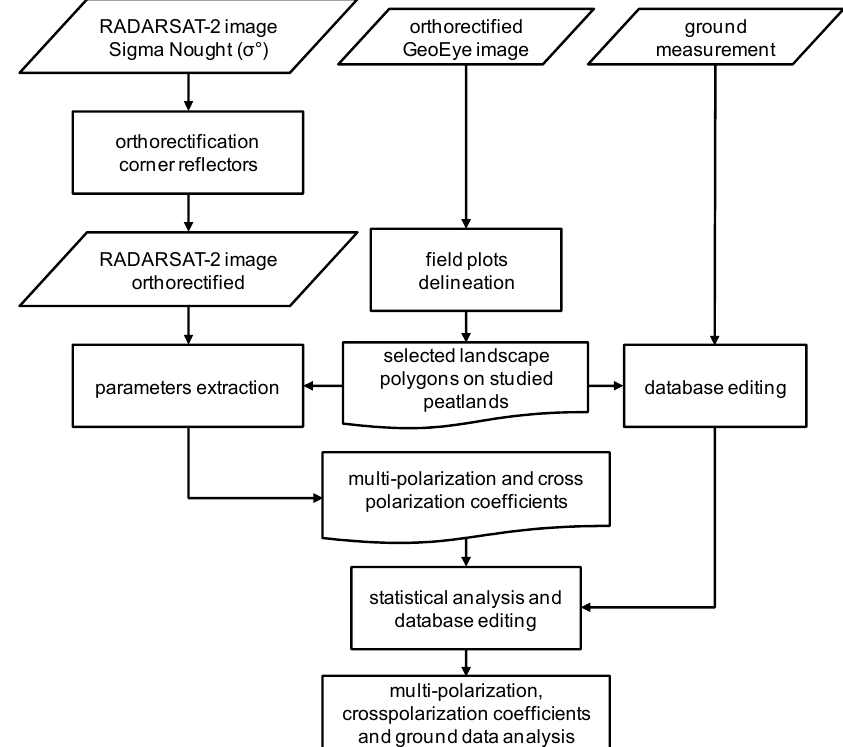
Figure 3. The data processing sequence to extract the backscattering coefficients and to compare with ground